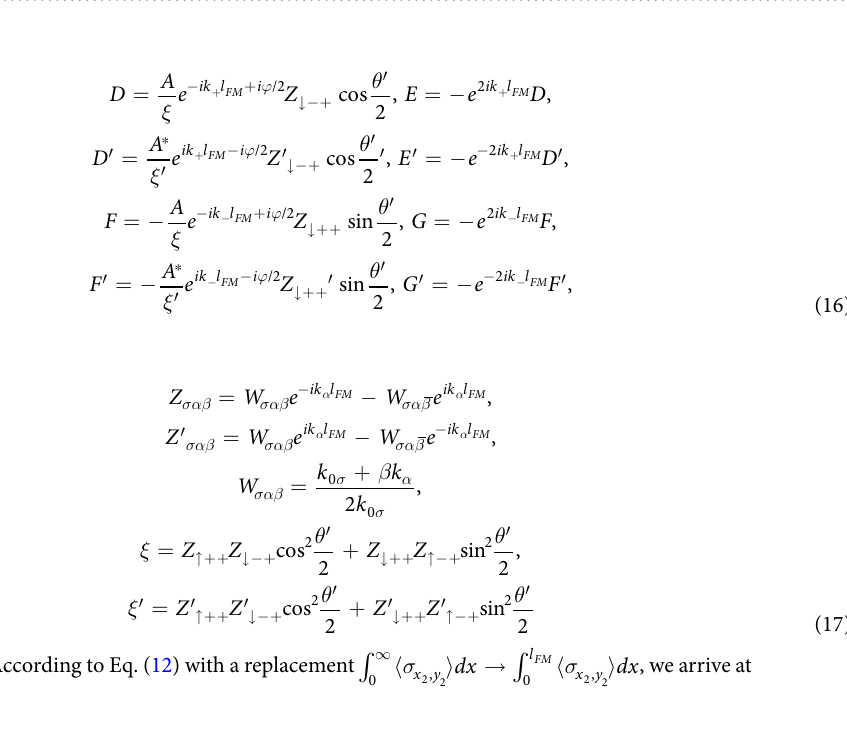
Figure 4. Schematic pictures similar to Fig. 1, but for the NM/FMM bilayer. Note that ν ( γ ) 0 in this